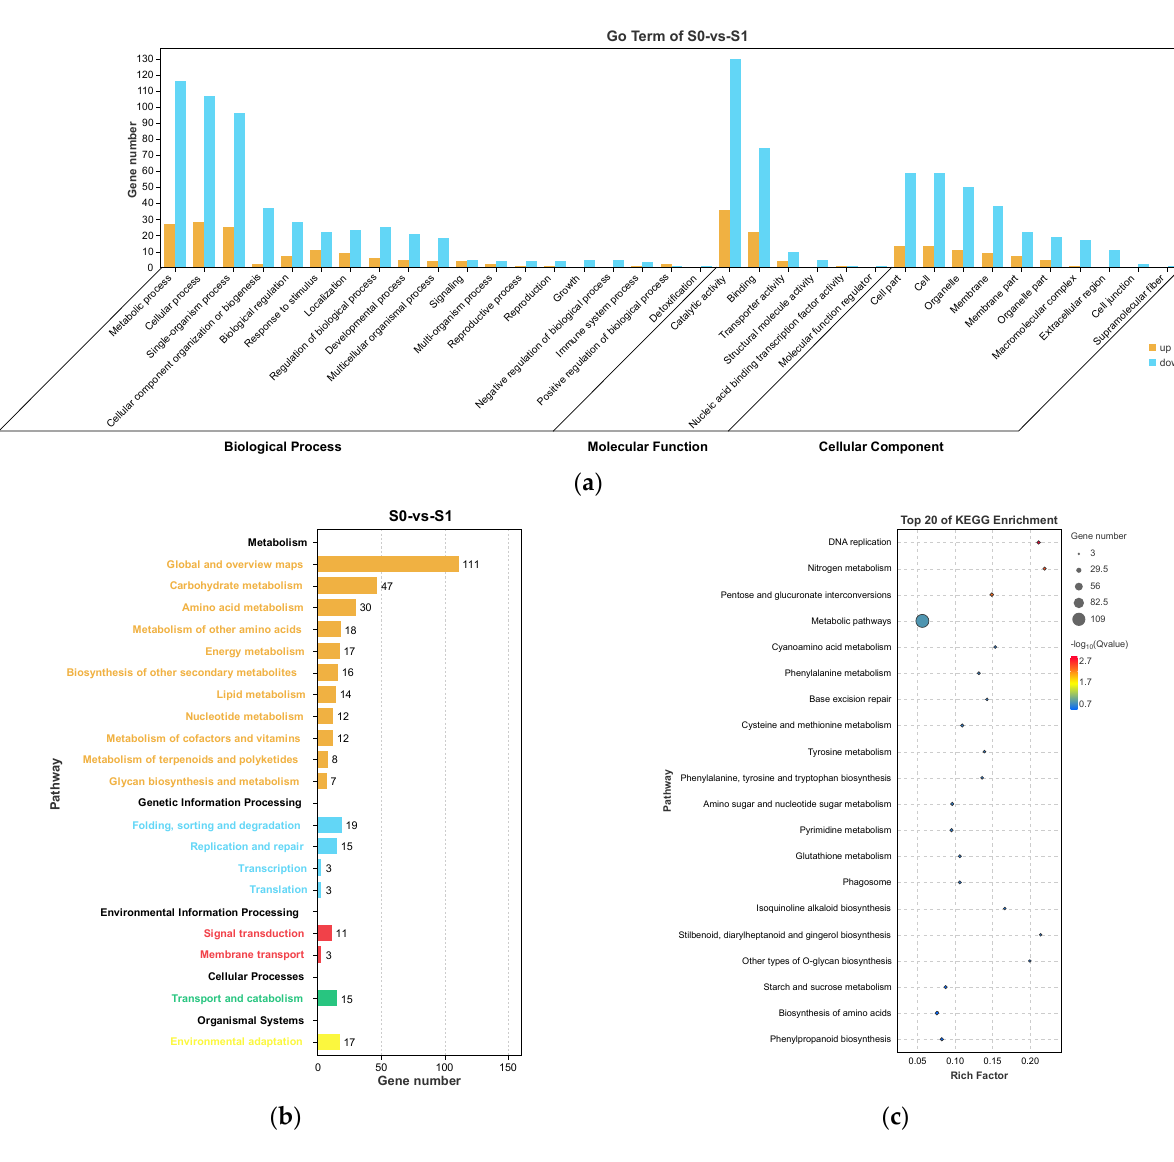
Figure 5. Gene Ontology (GO) enrichment ( a ), KEGG pathway annotation ( b ), and the top 20 KEGG pathways ( c ) of the differentially expressed genes (DEGs) in S0 vs. S1. The area of the bubbles indicates the number of enriched DEGs, while the color of bubbles represents the Q-value indicated in the panel to the right.